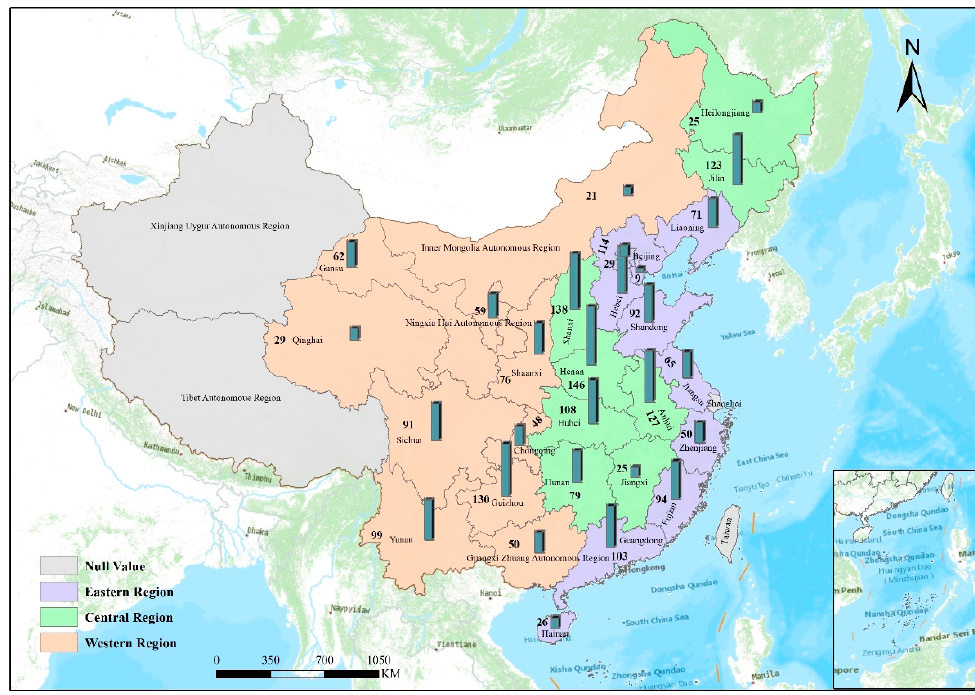
Figure 2. Distribution of household survey samples.